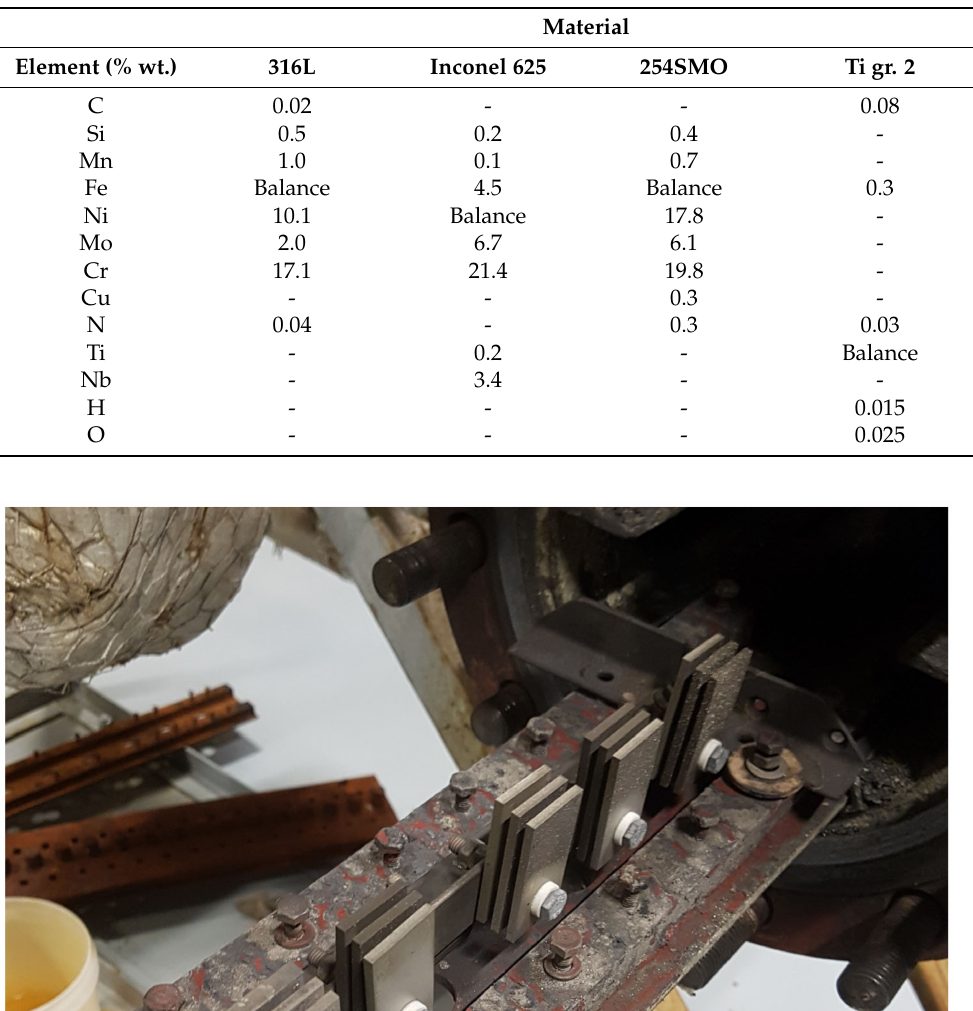
Table 2. Elemental composition of the materials tested in this work.